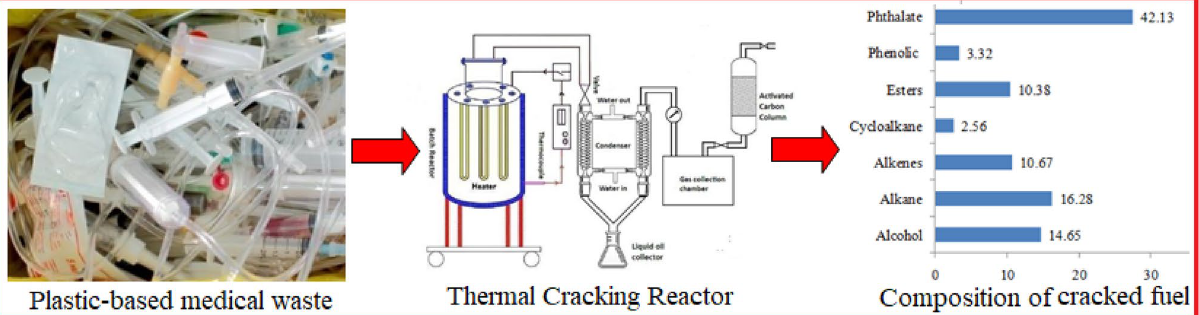
Figure 1. Graphical presentation of thermal cracking process for the production of liquid fuel oil from plastic based medical wastes and method of